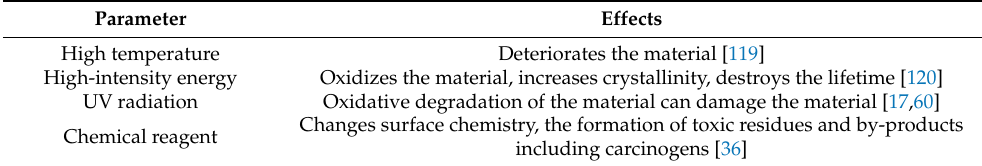
Table 8. Disadvantages of traditional parameters used for surface functionalization methods [118].